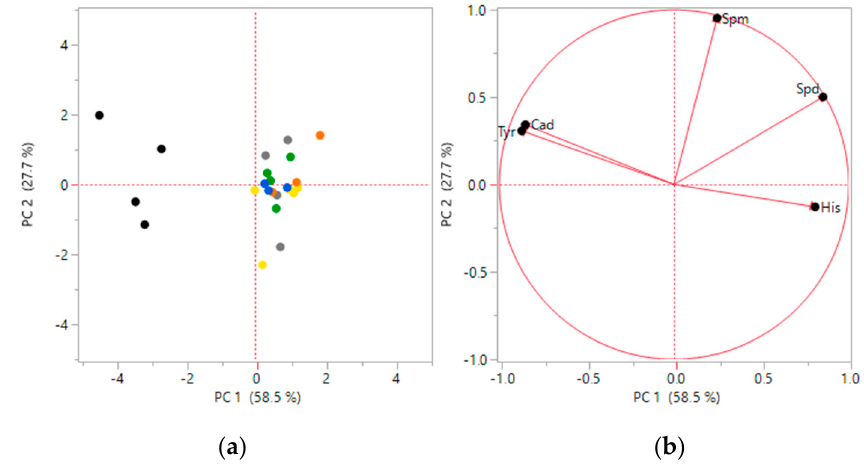
Figure 5. Scores plot ( a ) and loadings plot ( b ) of complete data set. Spelt: Blue, Oat: Orange, Millet: Yellow, Barley: Black, Quinoa: Green, Rice: Grey.